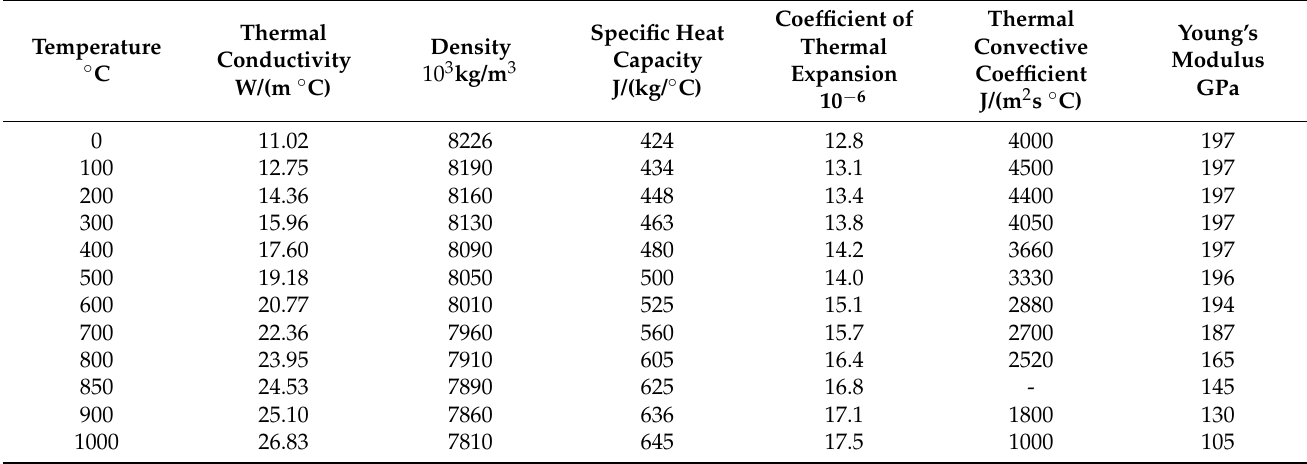
Table 2. Relationship between thermodynamic parameters and